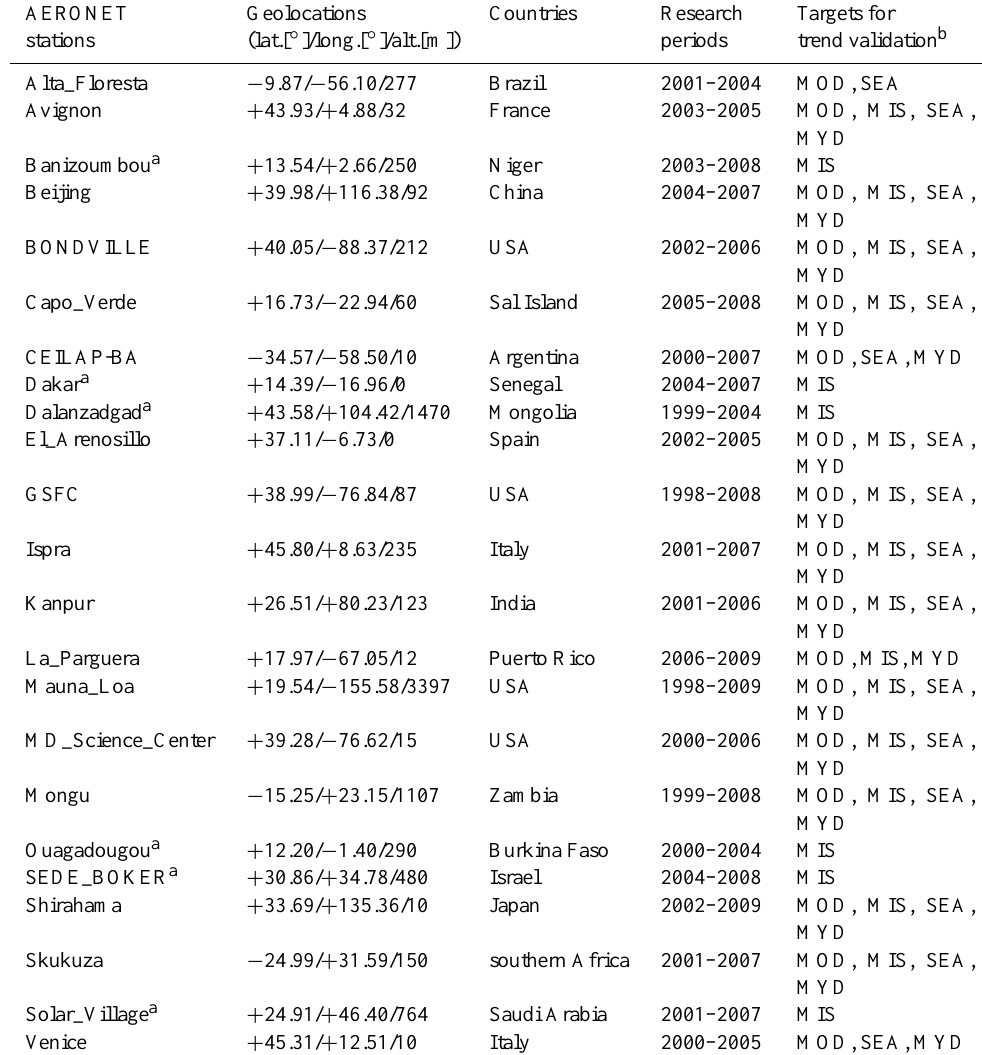
Table 4. Geolocations of AERONET stations and research periods of AERONET level 2.0 AOT data for the validations of the satellite-derived trends in Fig.